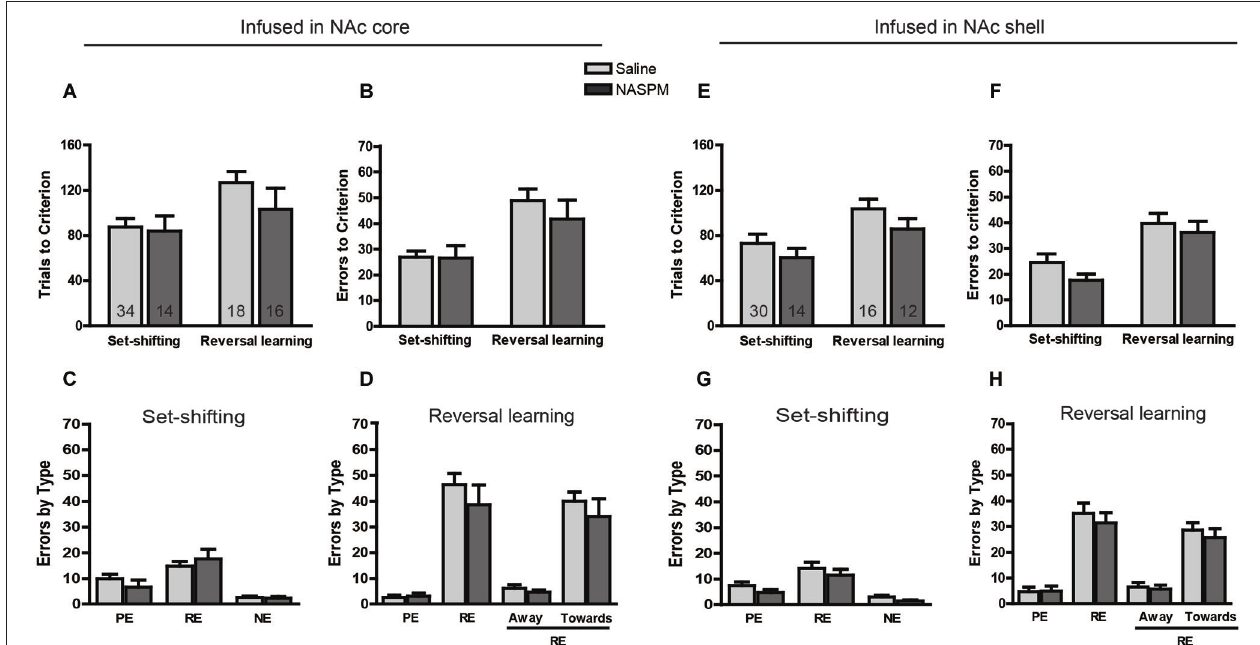
set-shifting (C) and reversal learning (D) in rats that received NASPM treatment in the NAc core. (E) Number of trials and (F) number of errors to reach criterion in the set-shifting and reversal learning tasks following intra-NAc shell infusions. (G,H) Analysis of the types of errors during set-shifting (G) and reversal learning (H) in rats that received NASPM treatment in the NAc shell. No changes were found in the set-shifting or reversal learning phase. PE, perseverative error; RE, regressive error; NE, non-reinforced error. During the reversal learning task, regressive errors were further divided into “away” and “toward” the visual